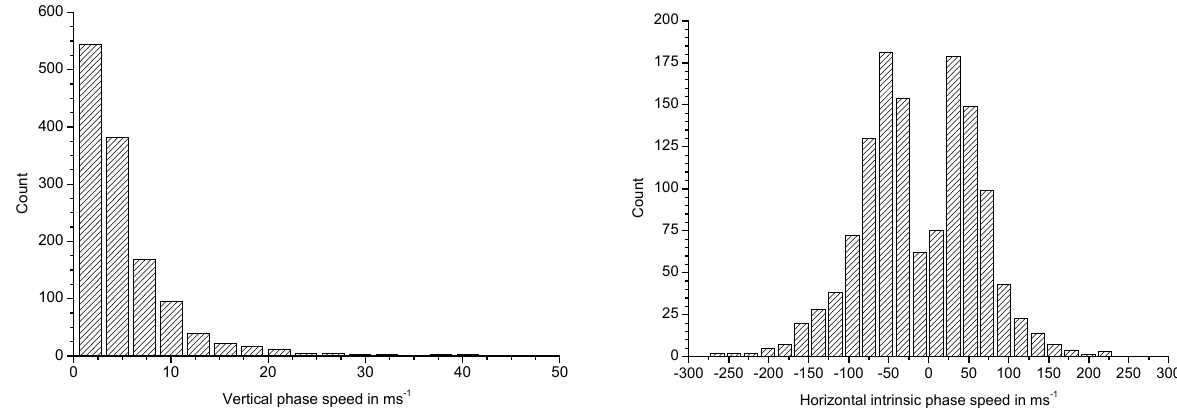
Figure 6: Histograms of observed vertical (left panel) and intrinsic horizontal phase velocities (right panel).